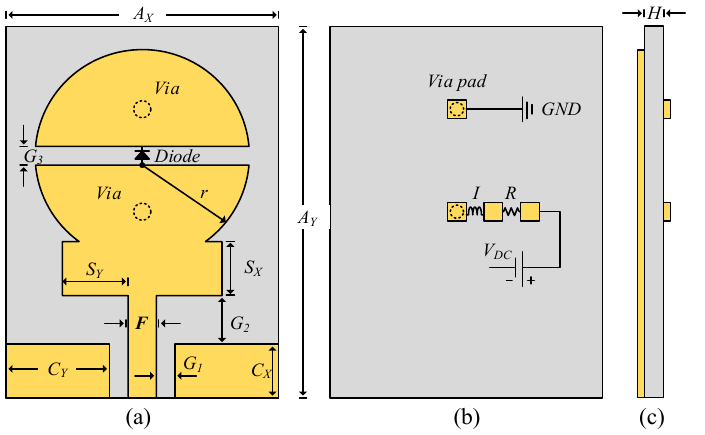
Figure 1. Schematic of proposed frequency reconfigurable antenna: ( a ) top-view, ( b ) bottom-view, and ( c ) side-view.